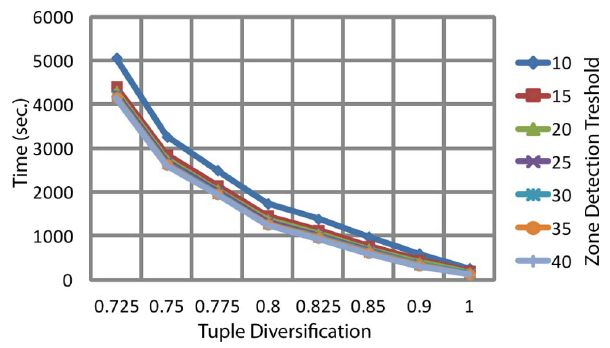
Figure 8. PSimScan processing time dependence on tuple diversification and similarity zone detection threshold. Strepto- coccus pneumoniae R6 proteome was used as the query set, SwissProt/ Uniprot database – as the subject set. Measurements were taken at mxshift =4.